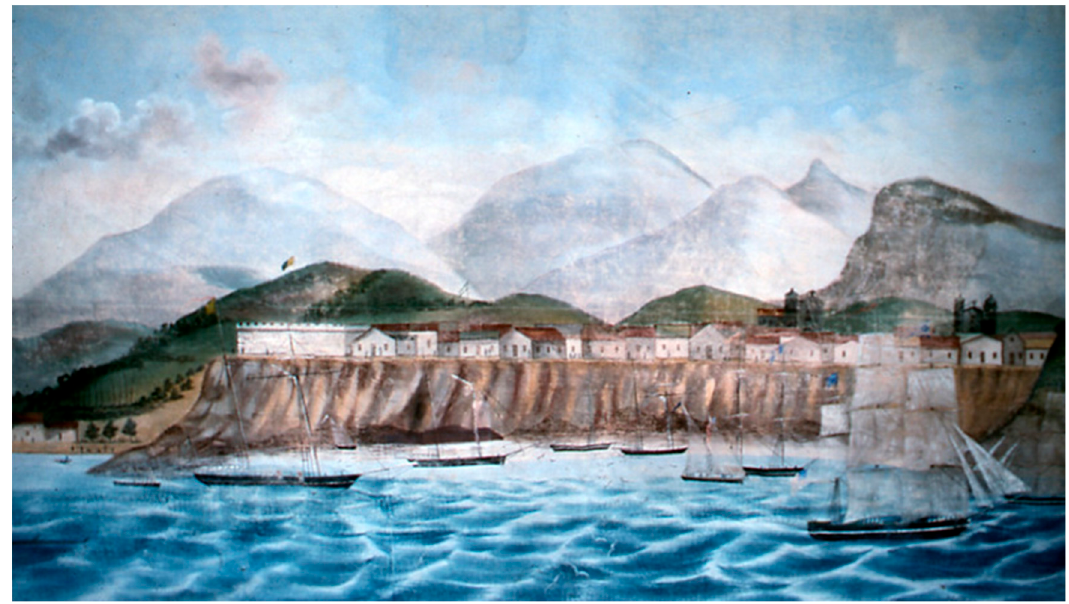
Figure 2. Port of Praya, Island of Santiago, in the Grand Panorama of a Whaling Voyage Round the World by Caleb Purrington and Benjamín Russell, 1847–1848. Courtesy of the New Bedford Whaling Museum.